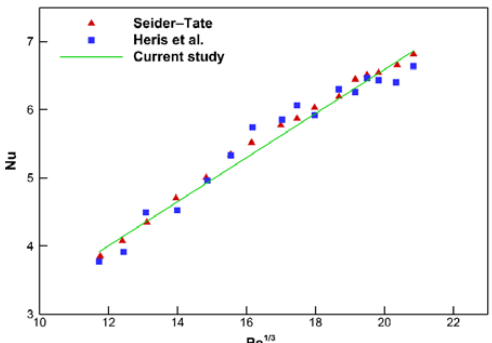
Figure 5. Comparison between the current simulation and those reported by Sieder–Tate [49] and Heris et al. [50] for water at the constant wall temperature.